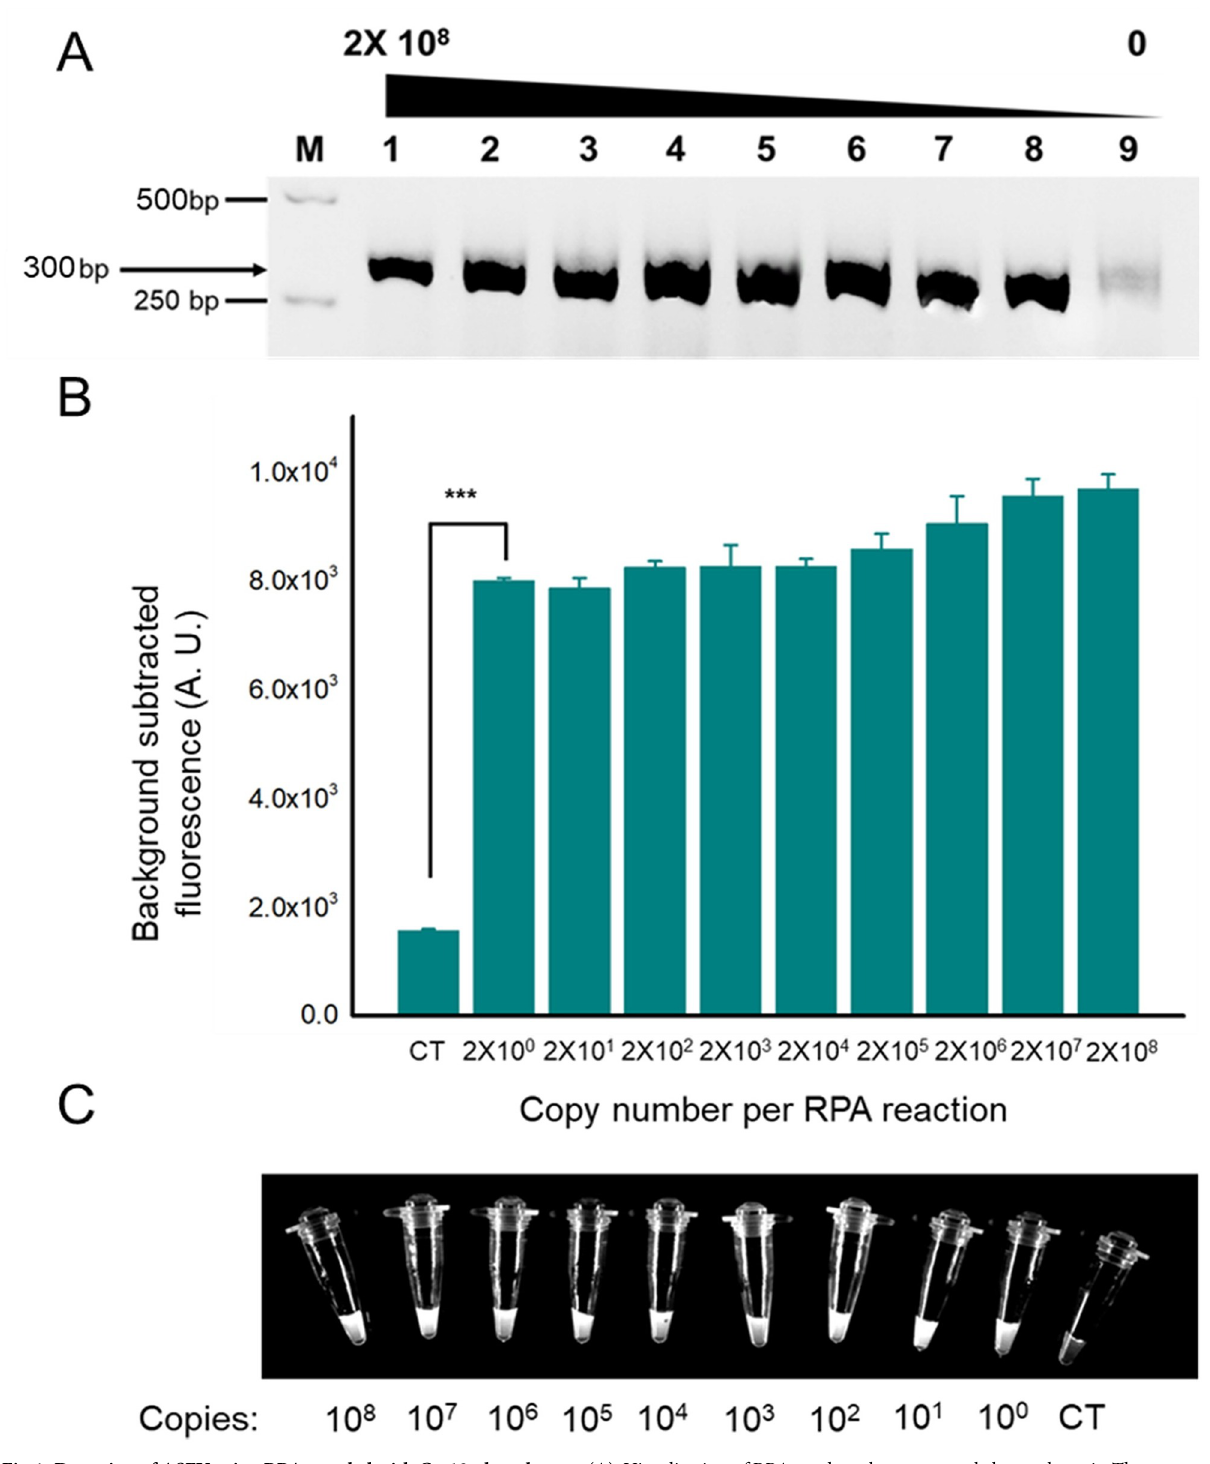
Fig 4. Detection of ASFV using RPA coupled with Cas12a-based assay. (A). Visualization of RPA products by agarose gel electrophoresis. The expected product size is 300 bp. (B). Reactions were performed after an RPA amplification of the virus DNA with varying initial concentrations, and it can detect as low as two copies of initial DNA. n = three technical replicates, bars represent mean ± SD, ��� p < 0.001. (C). Direct observation by the naked eye when the Cas12a reactions system is exposed to blue light. CT, negative control.